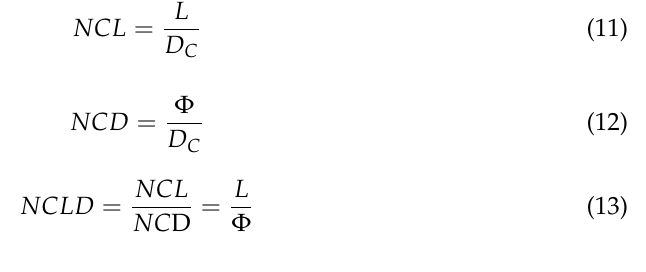
Table 1. Morphological parameters of the tested porous metal foams.